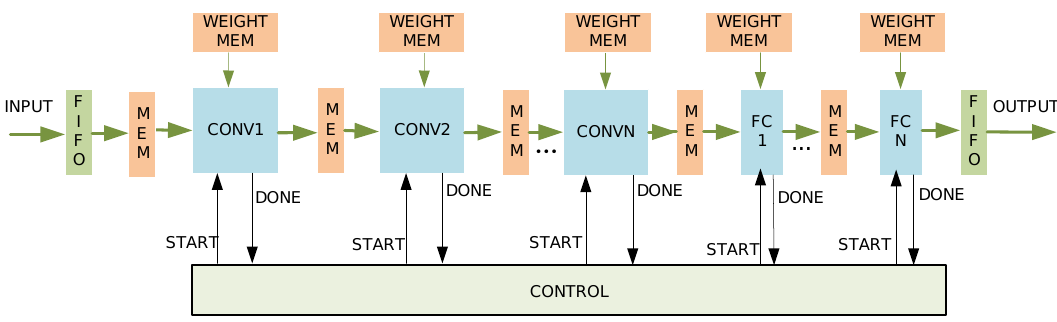
Figure 2. A generic overview of the CNN computing architecture.